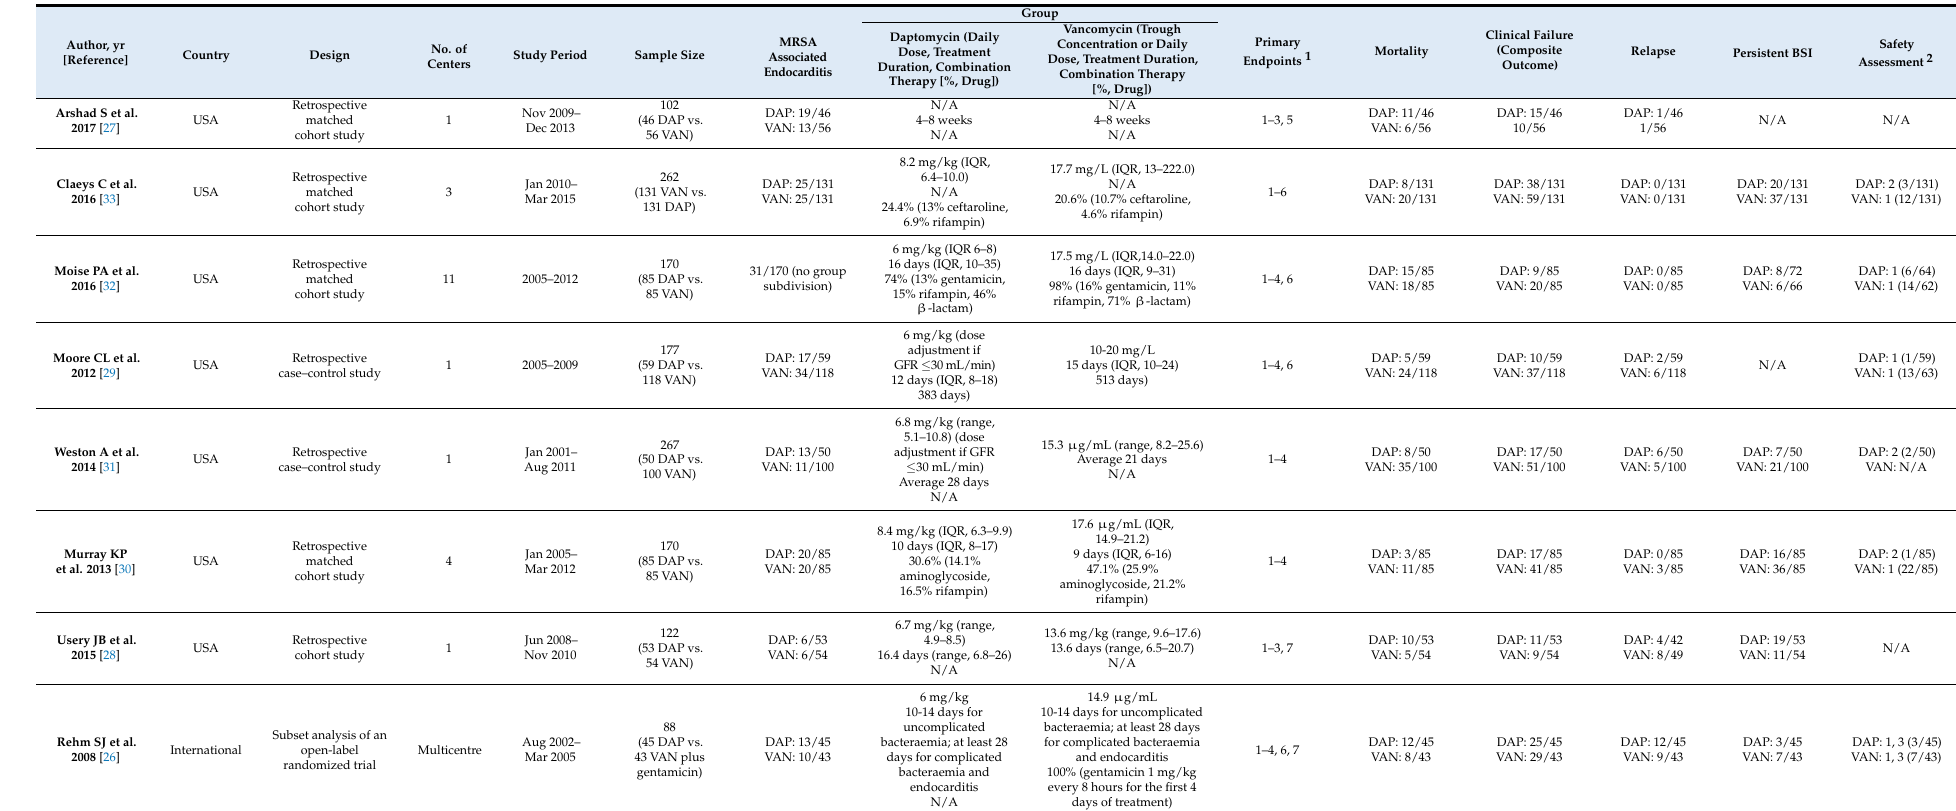
Table 1. Overview of included studies’ main